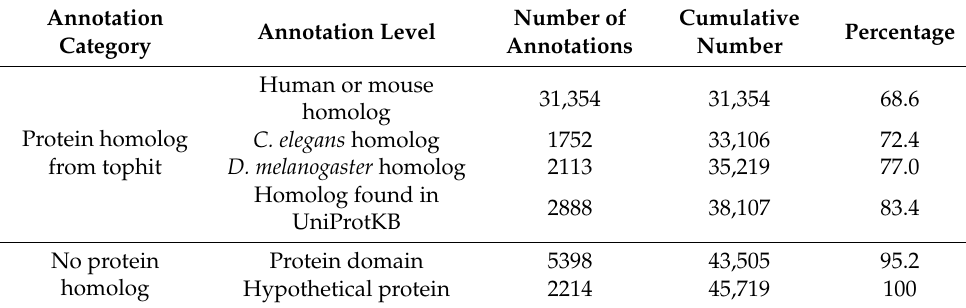
Table 4. Protein-level annotation for B. mori .